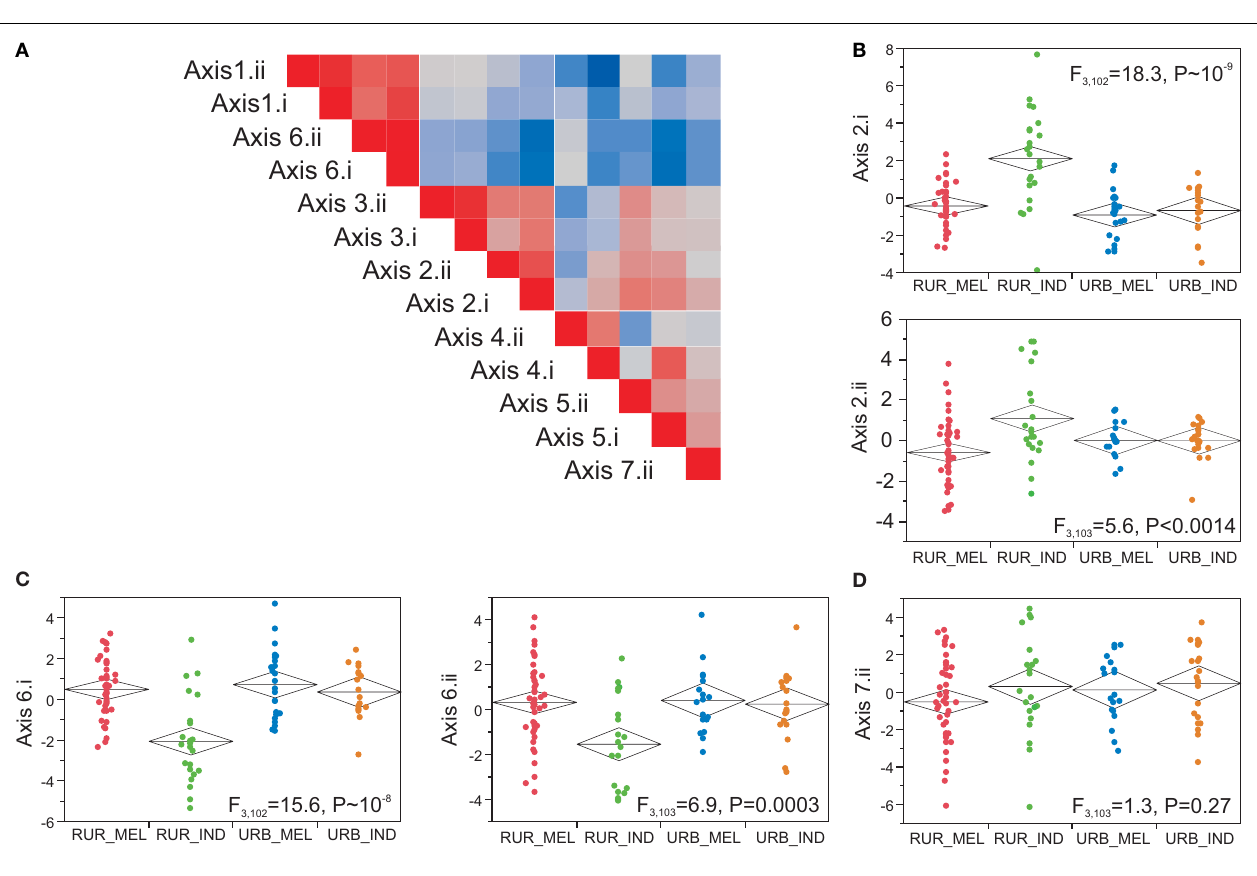
experiment.The remaining plots show the relationship between Axis scores and population sample as in Figure 3 , highlighting Axes 2 (B) and 6 (C) , contrasted with a non-significant trend for divergence of Axis 7 in rural Melanesians (D)